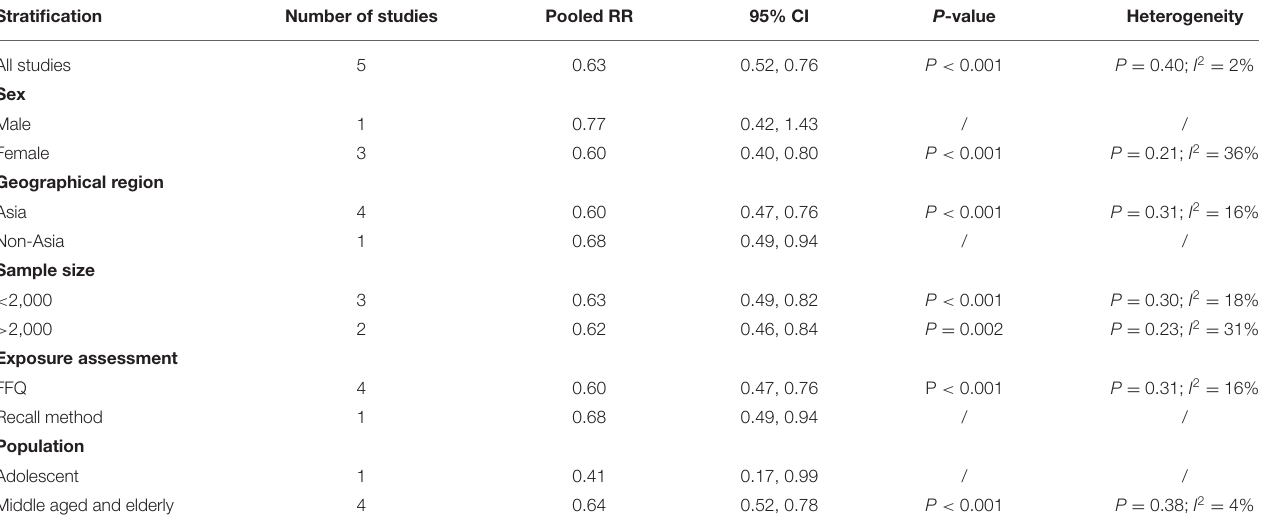
TABLE 2 | Subgroup analysis of depression for the highest vs. lowest dietary copper intake